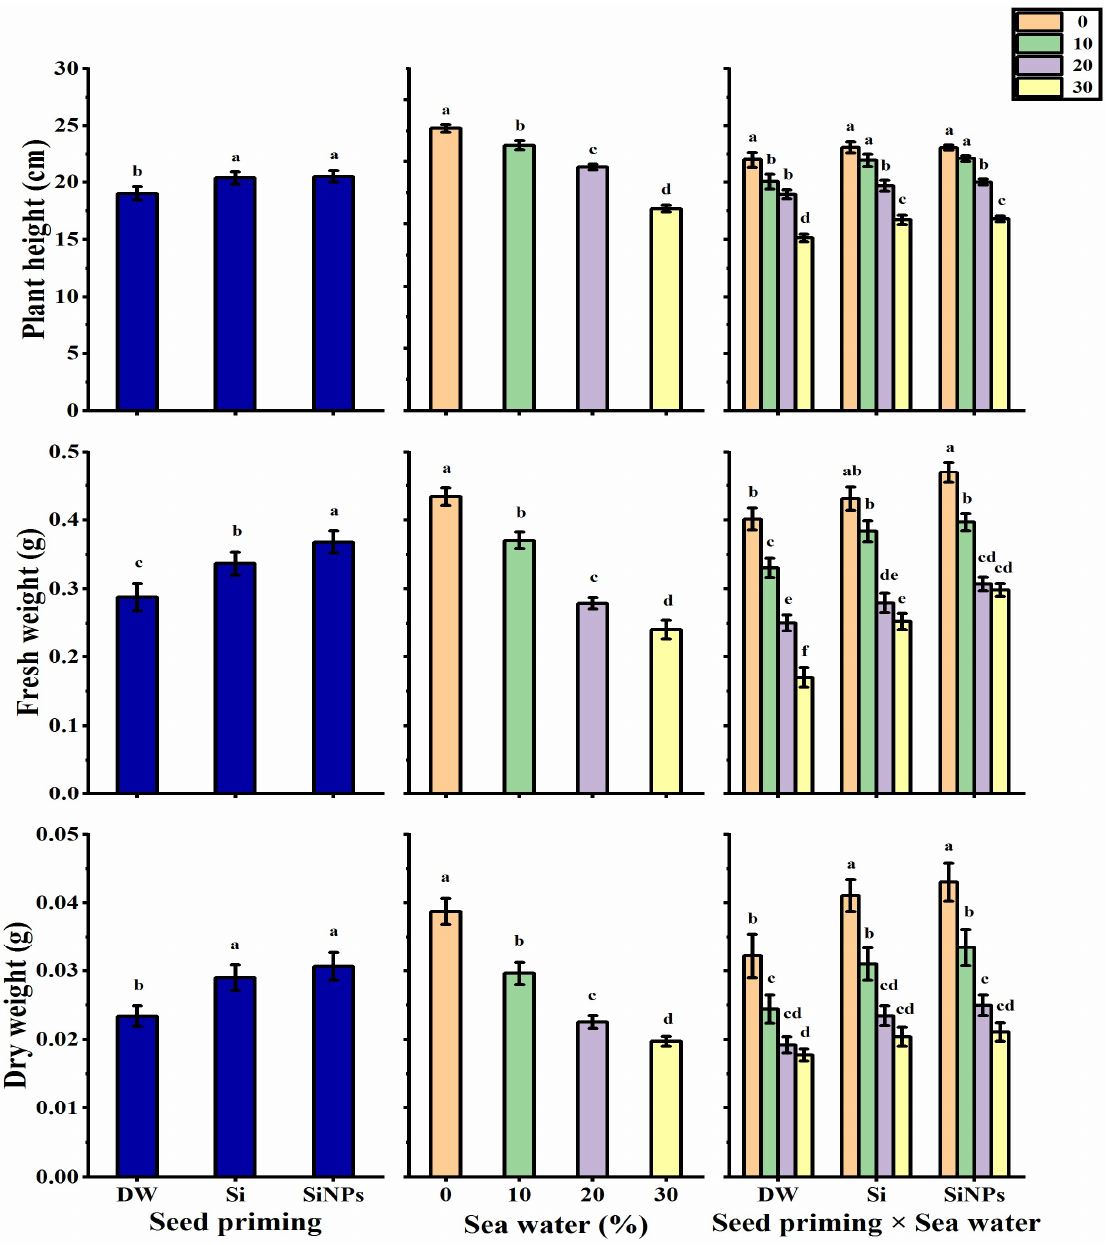
Figure 2. Effect of seed priming on plant height (cm), fresh weight (g), and dry weight (g) of Lathyrus odoratus seedlings irrigated with seawater levels (0, 10, 20, and 30%). Data are mean value ± SE. Bars with different letters are significantly different at p ≤ 0.05 level.